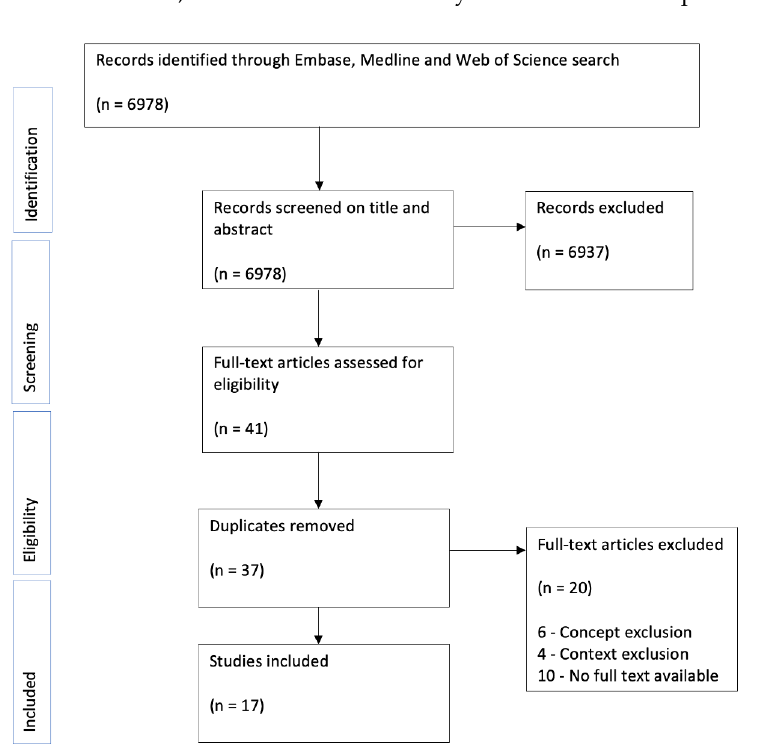
Figure 1. PRISMA flow diagram of study selection